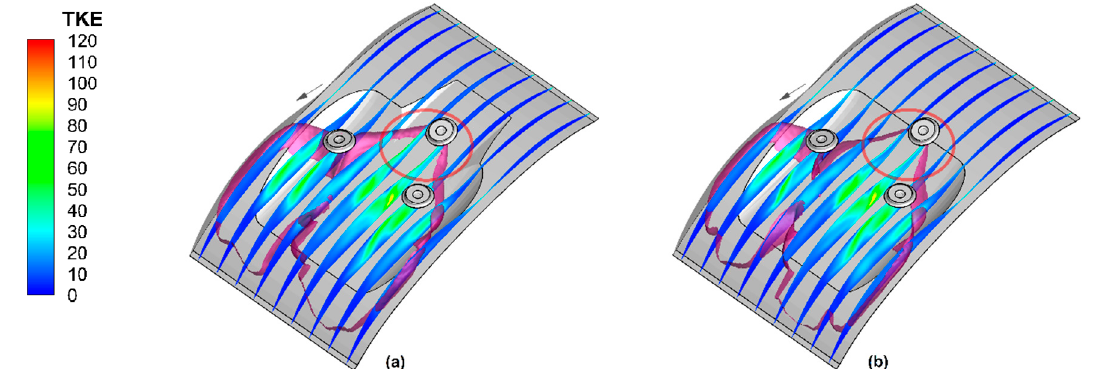
Figure 13. Distribution of TKE (m 2 /s 2 ) and representation of temperature iso-surface of 1500 K at 20°EA after TDC (40°EA after ST) for ( a ) L-slot (L-T-plug) and ( b ) N-slot (L-T-plug) cases.